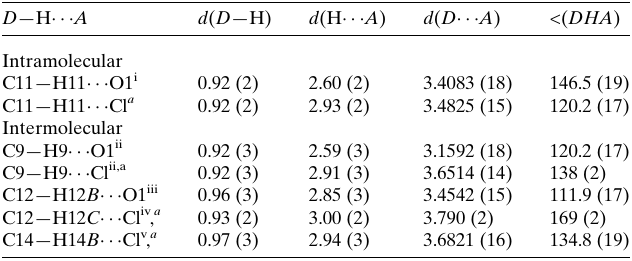
Table 1 Hydrogen bonds (A˚ , (cid:4) ) in the crystal of 3 .